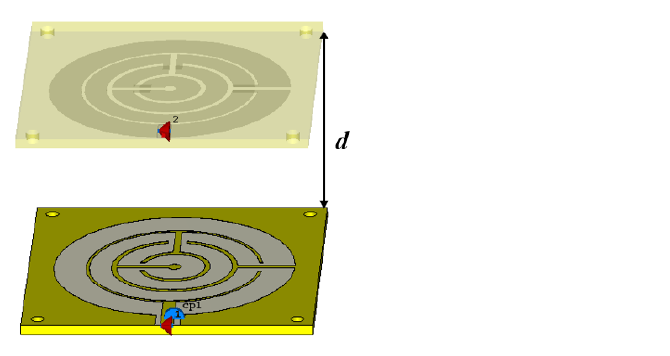
Figure 10. Schematic of wireless power link with proposed four-turn split-ring loops.